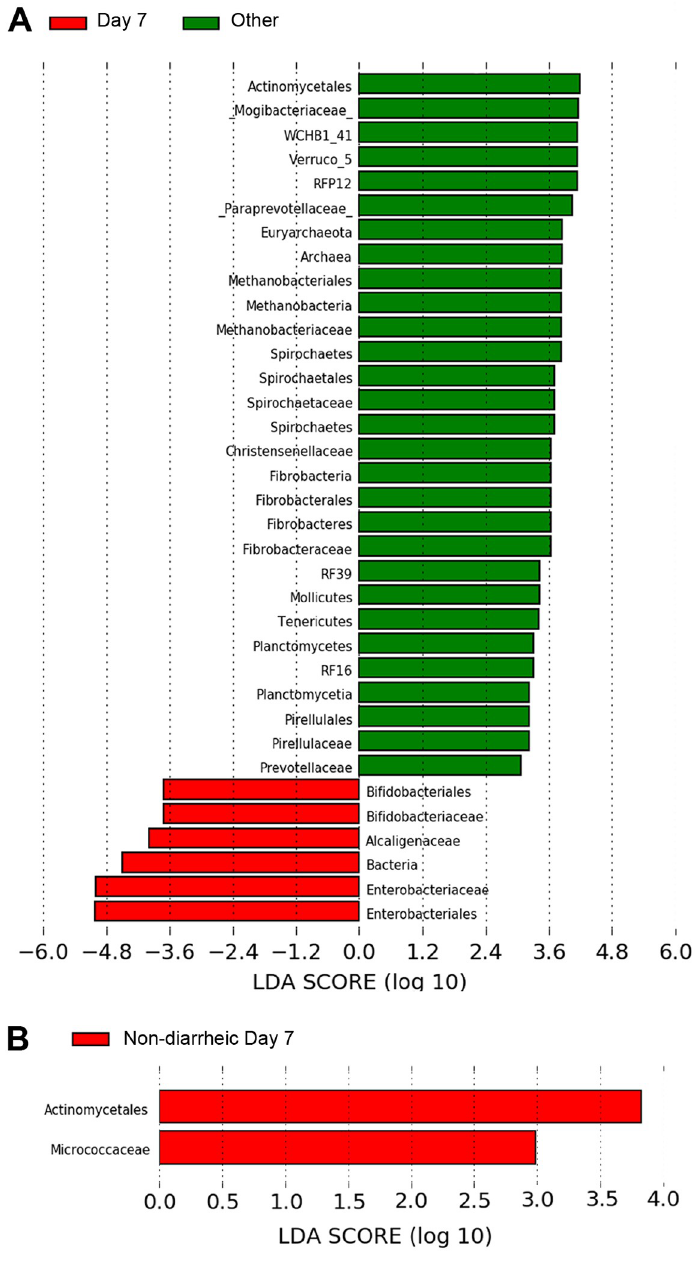
Fig 5. LEfSe distinguishes difference in relative abundance of bacterial families in diarrheic samples at Day 7. (A) Significant differences in microbial populations were examined for Day 7 diarrhea samples versus all other diarrhea samples. (B) Differences between microbial populations of Day 7 diarrhea samples versus non-diarrheic samples were also considered. Significant differences were found by Kruskal-Wallis (KW) rank-sum test, and reported in log 10